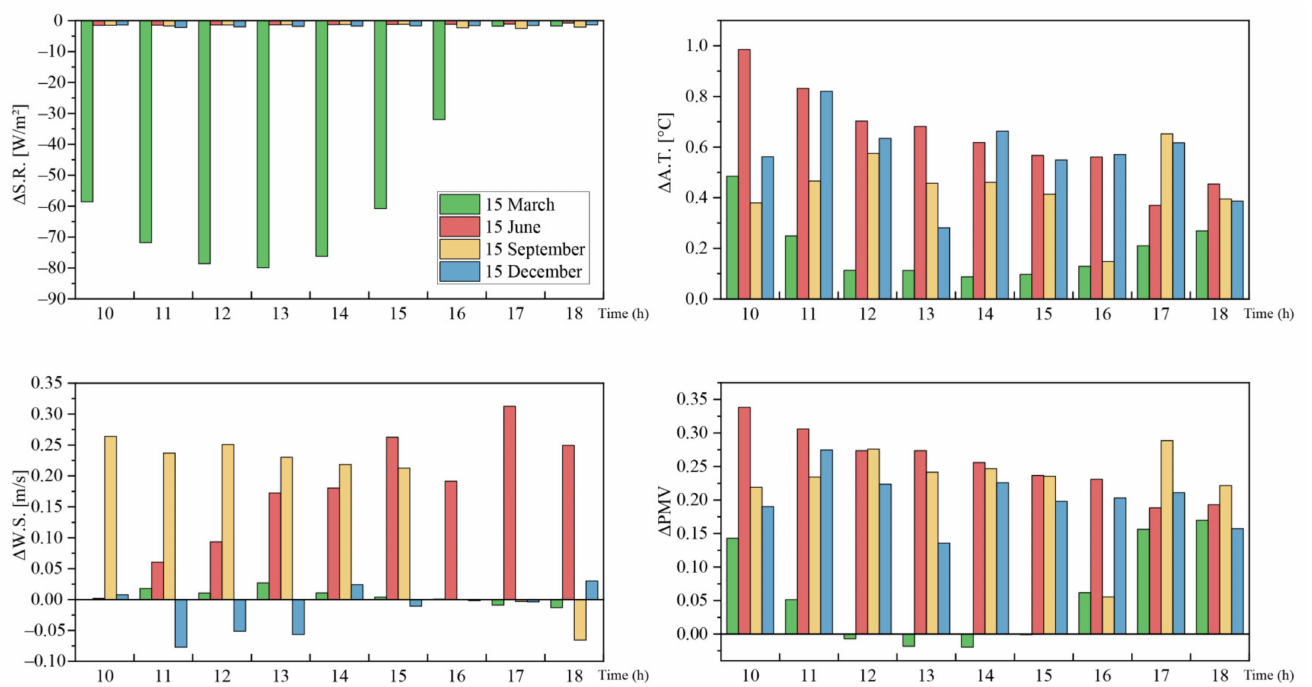
Figure 13. Average comparison in the microclimate and comfort between two models at a height of 1.2 m on four days. (Comparison ( ∆ ) = Tree model simulation minus treeless model simulation; S.R. = solar radiation; A.T. = air temperature; W.S. = wind